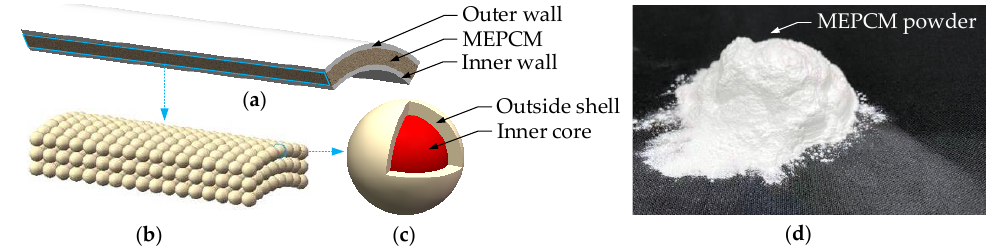
Figure 3. Thermal insulation of the variable stiffness endoscopic manipulator: ( a ) layer structure of the thermal insulation; ( b ) macroscopic view of the MEPCM layer with filling desity of 0.75 g/mL; ( c ) microcapsule in microscopic view; ( d ) physical map of the MEPCM powder with stacking density of 0.45